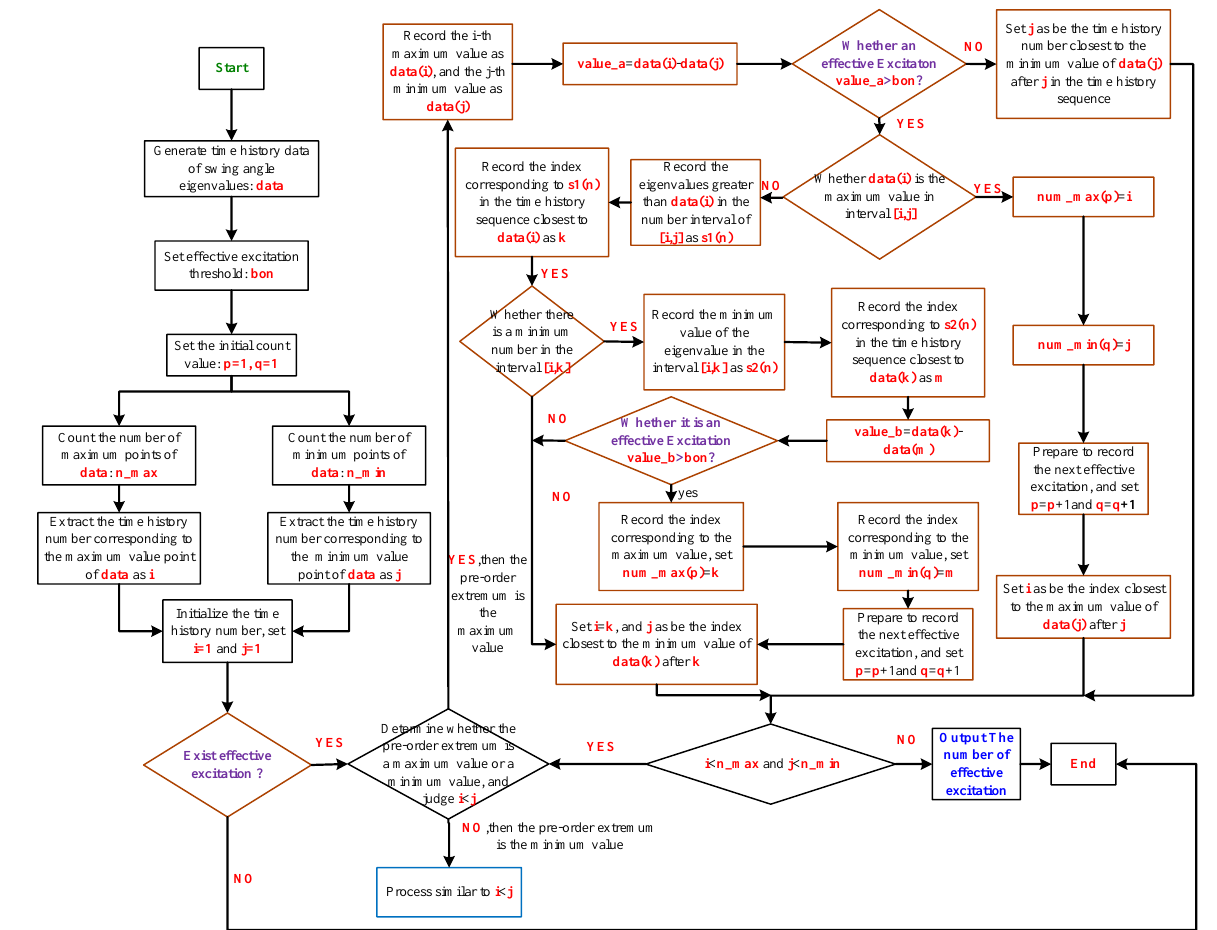
Figure 11. The statistical method of calculating the number of effective excitations. The critical value of the swing motion was influenced by the mass of the eccentric rotor, the coefficient of friction at the central axis, the damping of the energy conversion system, etc. There were differences in critical values for various ERWEC devices. The crit- ical value of swing amplitude of the ERWEC physical model developed in this paper was 15° according to several experimental measurements. Taking Experiment Dg as an example, the motion response of the buoy around the ox axis is shown in Figure 12. The red line represents the forward effective excitation of the buoy rotating clockwise around the ox axis, and the blue line represents the backward effective excitation of the buoy rotating counterclockwise around the ox axis, and the sum of the forward and backward effective excitations is the number of effective excitations around the ox axis. For example, the number of effective excitations around the ox axis in Experiment Dg was 51. The number of effective excitations is used to evaluate the effect of the motion response of the buoy under different mooring systems and different wave conditions. Figure 12. The motion response of the float around the ox axis. 4.2. The Number of Effective Excitations in the Single-Anchor Line Mooring Mode The number of effective excitations obtained for the buoy in the single-anchor line mooring mode is shown in Figure 13. The horizontal coordinates indicate the number of effective excitations, and the vertical coordinates indicate the corresponding experiment number. The blue color indicates the number of effective rotations of the ERWEC around the ox axis, and the orange color indicates the number of effective rotations of the device around the oy axis. When the length direction of the buoy is parallel to the wave incidence direction, the dominant wave excitation is around the oy axis. When the length direction of the buoy is perpendicular to the wave incidence direction, the dominant wave excita- tion is around the ox axis. That means the dominant wave excitation is around the axis perpendicular to the wave incidence direction.